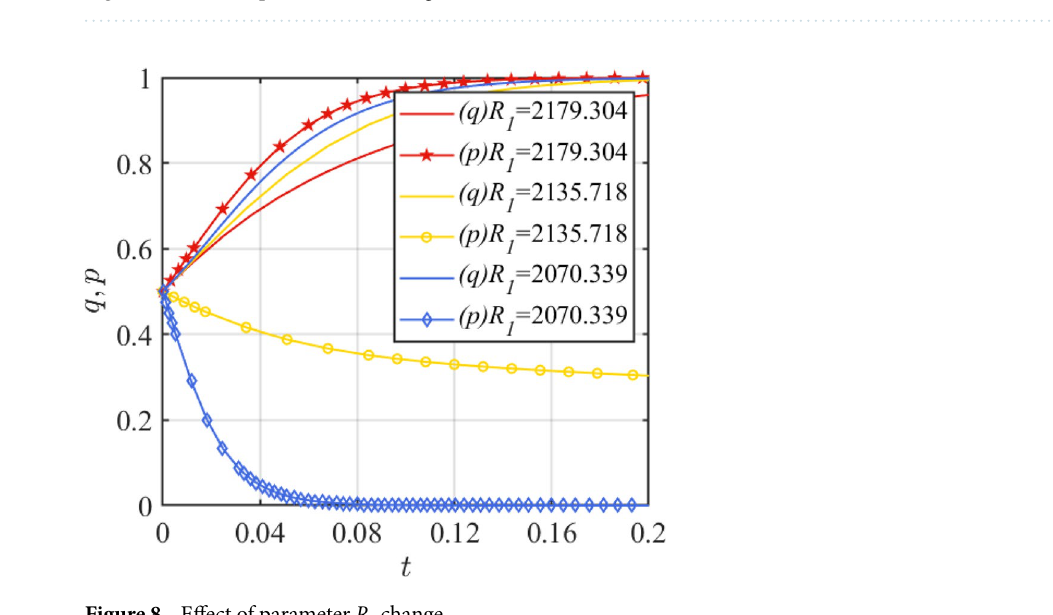
Figure 7. Effect of parameter C 1 change.